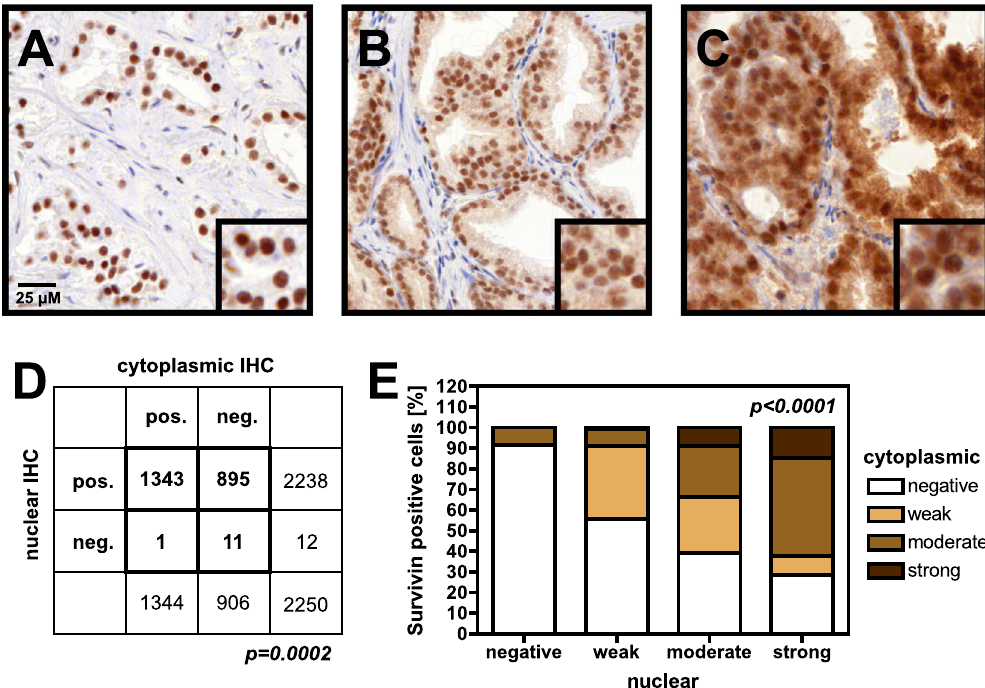
Figure 2. Survivin staining pattern and intensities of selected tissue microarray cores. Microphotographs (and magnifications thereof) showing nuclear only ( A ) as well as both nuclear and additional cytoplasmic ( B , C ) survivin staining of different intensities in prostate cancer cells. Comparisons of survivin-positive (pos.) or negative (neg.) prostate-cancer samples by subcellular localization are shown in ( D , p = 0.0002). Pearson’s χ 2 test). Staining intensities and frequencies by subcellular localization (cytoplasmic IHC relative to nuclear IHC) are shown in ( E , p < 0.0001, Pearson’s χ 2 test).